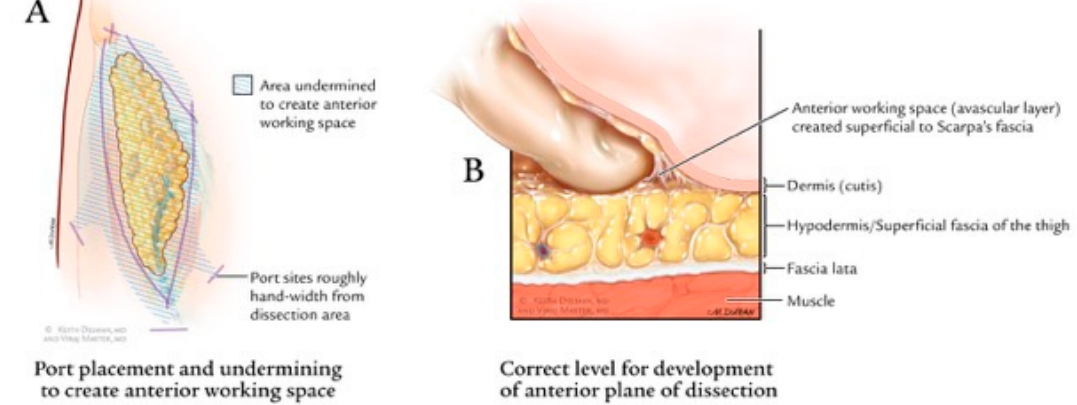
Figure 3. ( a ) Boundaries of dissection as well as area undermined to create anterior working space. ( b ) Correct level for development of anterior plane dissection. Copyright owned by Master et al.